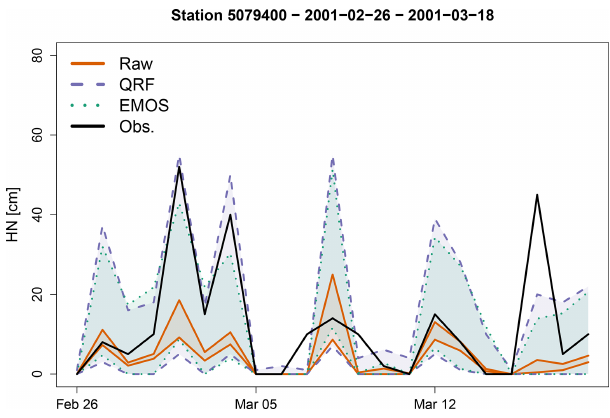
Figure 3. Time series of the raw reforecasts for a 1d lead time (orange plain lines) and predictive quantiles using QRFs (purple dashed lines) and EMOS (green dotted lines) during March 2001 for the station 5079400. For each of the three prediction systems, the lower and upper curves represent the 10th and 90th percentiles, respectively. The solid black line represents the time series of the HN observations.